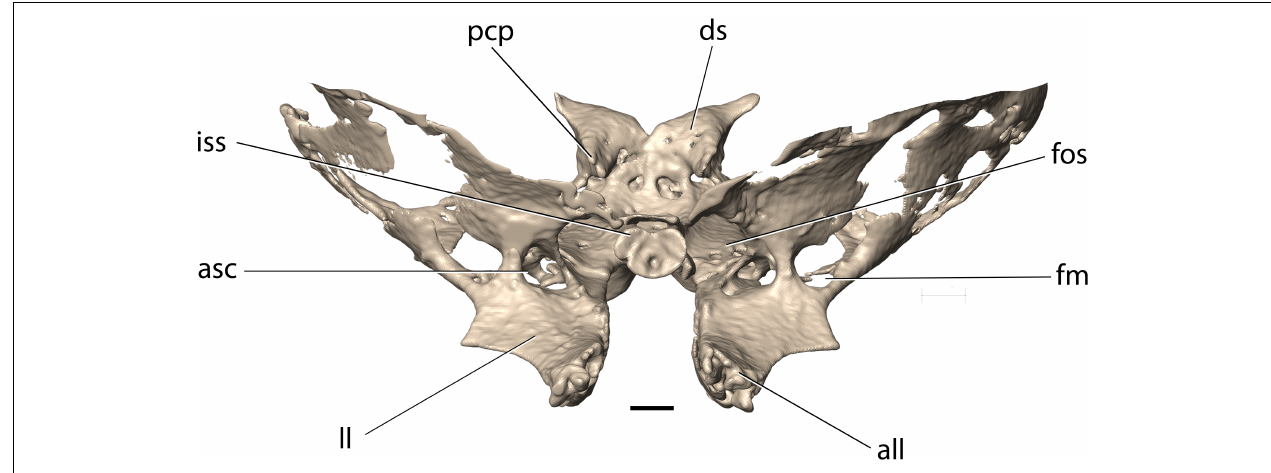
FIGURE 9 | Basisphenoid of Palaeolagus haydeni (FMNH PM9476) in anterior view (portions adjacent to alisphenoid crests removed). asc, alisphenoid canal; all, apex of lateral lamina of pterygoid; ds, dorsum sellae; fm, masseteric foramen; fos, superior orbital fissure; iss, presphenoid surface of intersphenoidal synchondrosis; ll, lateral lamina of pterygoid; pcp, posterior clinoid process. Scale bar = 1